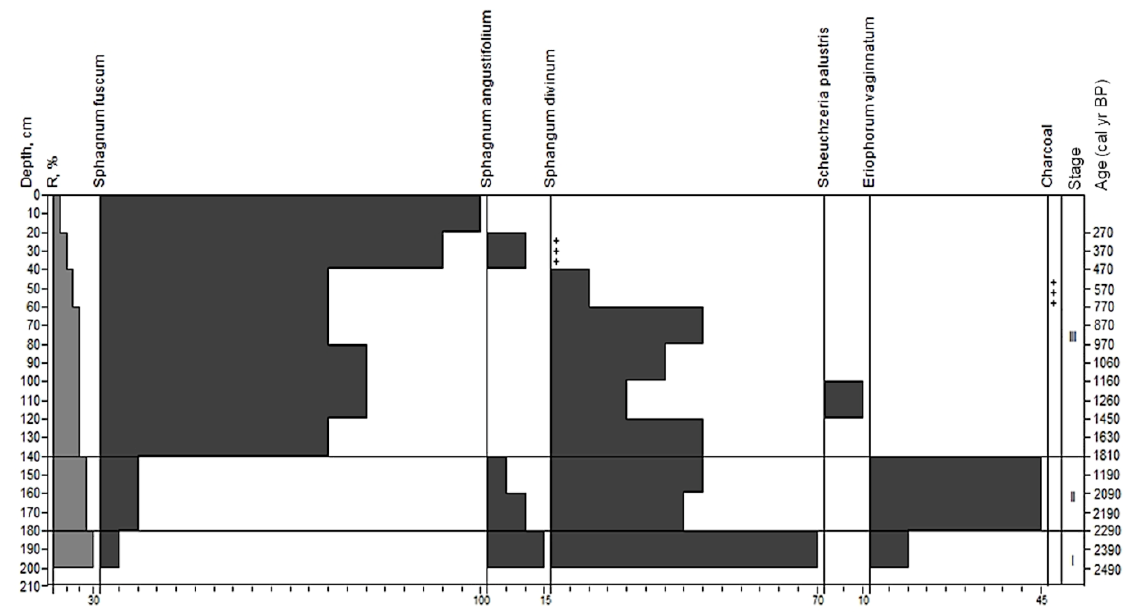
Figure 6. Macrofossil diagram for site 3. Stages correspond to paleo-communities: ( I ) — herbs- Sphag- num divinum + S. angustifolium ; ( II ) — Eriophorum vaginatum - Sphagnum divinum ; ( III ) — Ericales - Sphag- Sphagnum divinum + S. angustifolium ; ( II )— Eriophorum vaginatum - Sphagnum divinum ; ( III )— Ericales - num fuscum + Sphagnum divinum ; + — abundance less than 5%. Sphagnum fuscum + Sphagnum divinum ; +—abundance less than